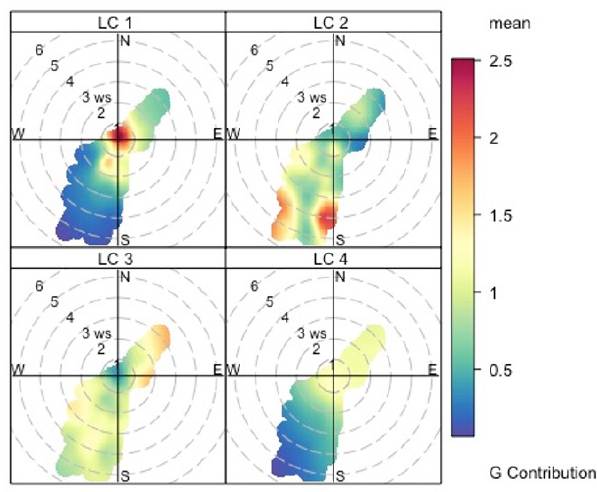
Figure 5. Polar plot of the average G contributions of the factors from the LC analysis.